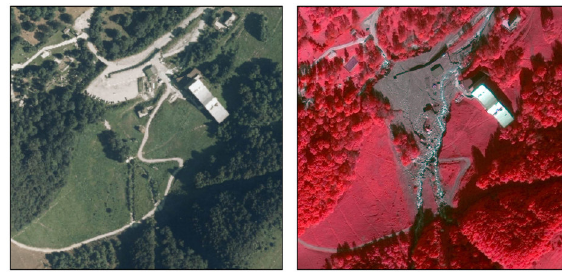
Figure 11 . Multi-temporal comparison of a flood-affected area. Reference orthoimagery, visible composite (Regione Piemonte WMTS service, AGEA © 2018, left) vs satellite post-event data, NIR false color composite (5 October 2020,